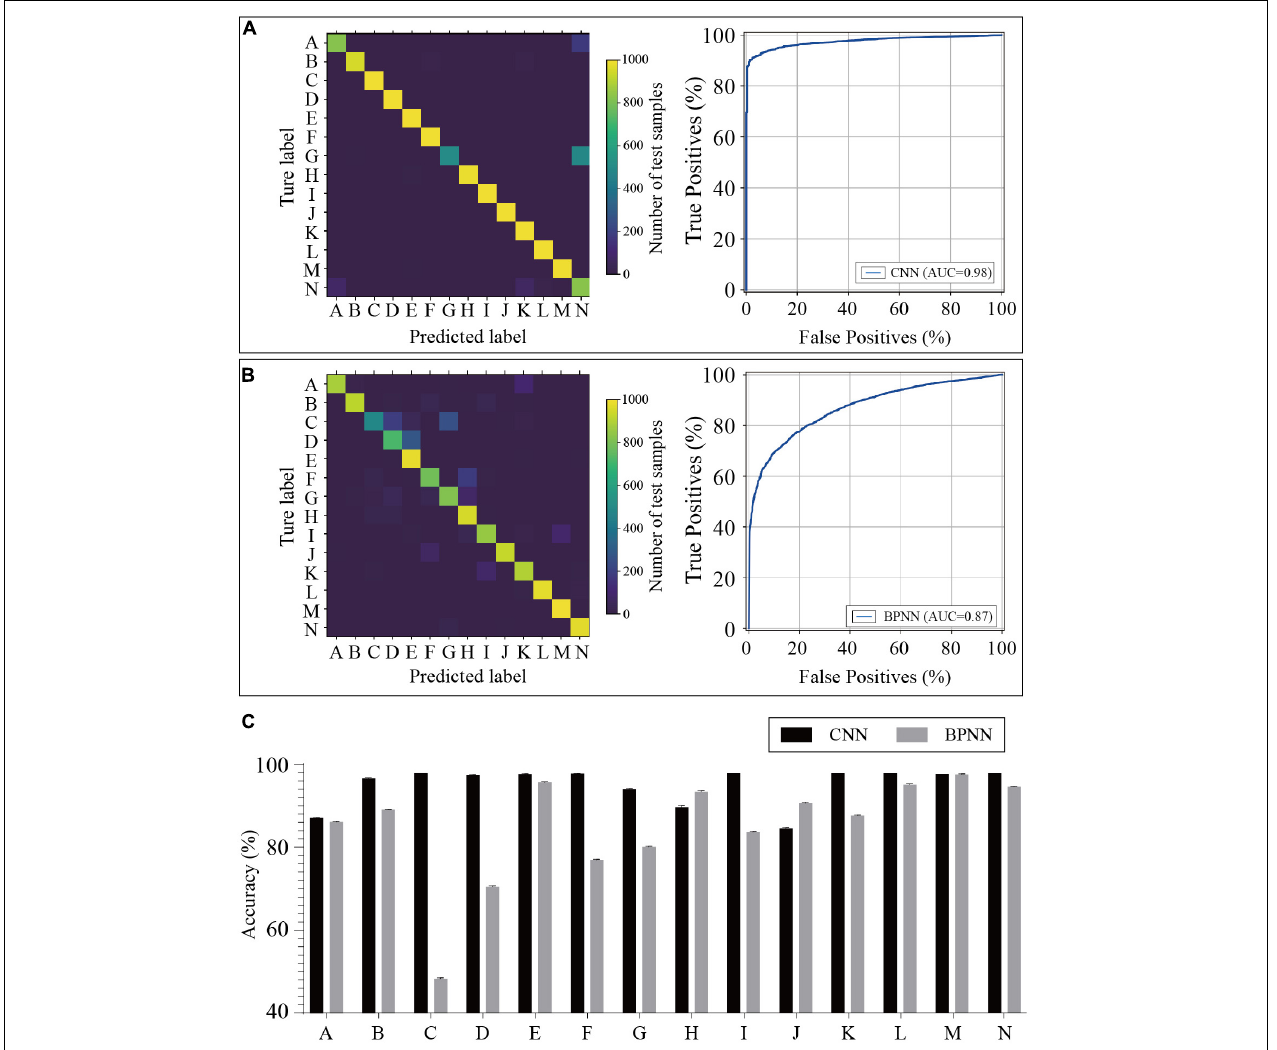
FIGURE 4 | Predicted results of the bacterial species based on the CNN and BPNN models. Confusion matrices and receiver operating characteristic curves of the CNN (A) and BPNN (B) models are plotted based on the extent of matching between the predicted labels and true labels. (C) The accuracies are calculated by the prediction model using test samples. CNN, convolutional neural network. BPNN, back propagation neural network. The annotation of labels A to N related to the species that are listed in Supplementary Table 1